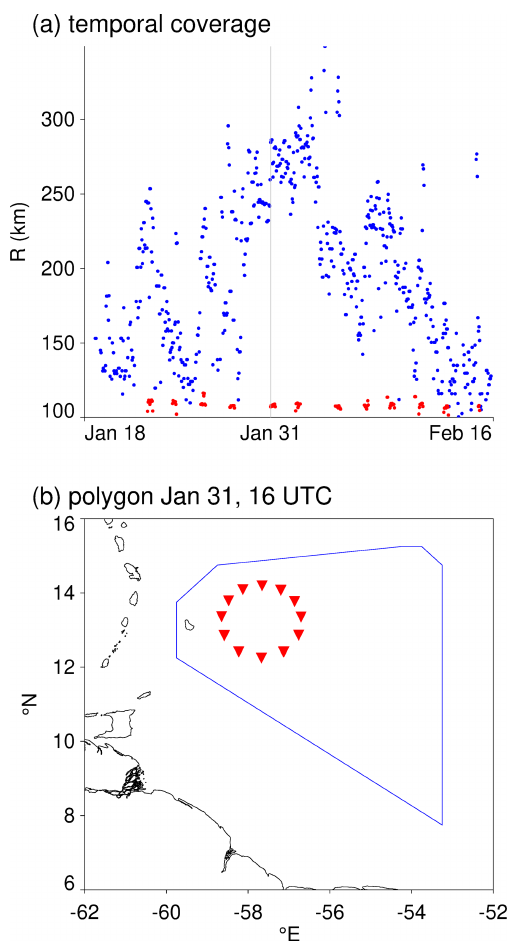
Figure 1. (a) Equivalent radius of the areas sampled by the sound- ing network (blue) and the HALO circles (red) over the period of the campaign. All points fulfill L/R < 2 (see the text for details). (b) For 31 January 2020 at 16:00UTC an example of a polygon spanned by radiosoundings (blue) and the location of dropsondes from the HALO circle